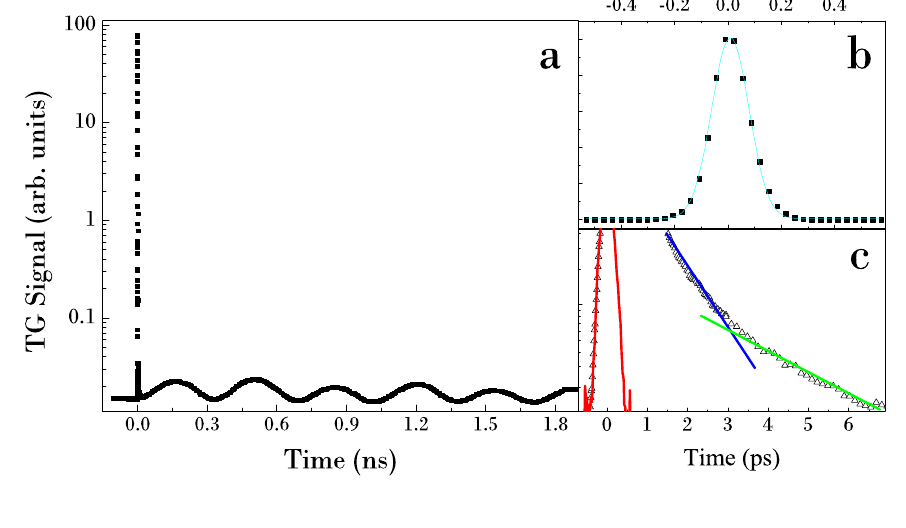
Figure 5. Panel ( a ) homodyne detected TG signal on DMSO at room temperature. Panel ( b ): electronic response from SiO (instrumental function) with gaussian curve fit (cyan 2 line). Panel ( c ): electronic and fast response on DMSO; the green and blue lines indicate the two contributions to the relaxation dynamics; the red line is the instrumental